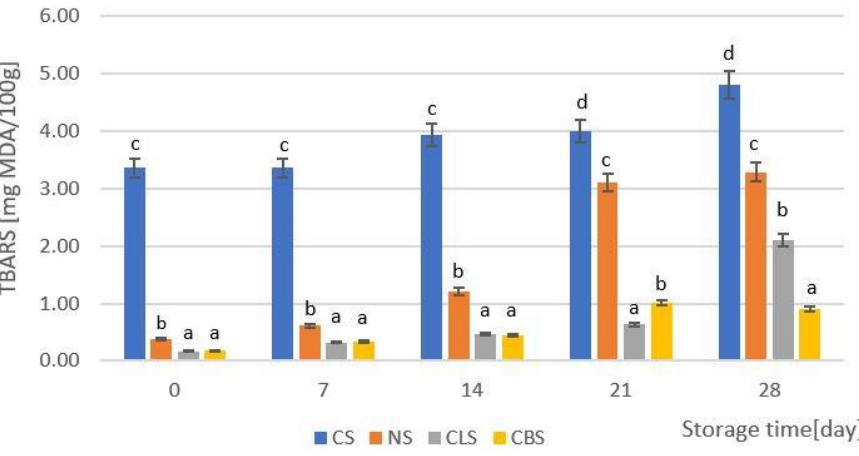
Figure 1. Effects of C. incanus extract with lycopene and betanin on lipid oxidation in vacuum packed pork sausages stored at 2 ± 1 °C. The results are expressed as mean ± SD, n = 3. CS, sausages with salt; NS, sausages with curing salt; CLS, sausages with C. incanus extract and lycopene; CBS, sausages with C. incanus extract and betanin; a–d, statistically differences between the sausage variants ( p < 0.05).